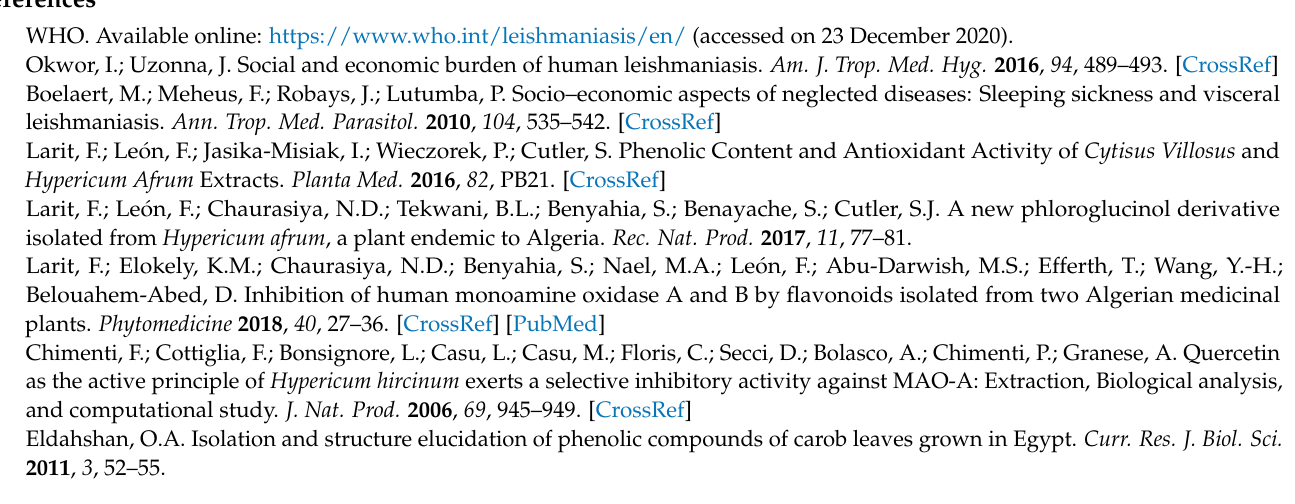
compound 1 , Figure S2: 13 C-NMR spectrum of compound 1 , Figure S3: Positive HRESIMS of compound 1 , Figure S4: 1 H-NMR spectrum of compound 2 , Figure S5: 13 C-NMR spectrum of compound 2 , Figure S6: Negative HRESIMS of compound 2 , Figure S7: 1 H-NMR spectrum of compound 3 , Figure S8: 13 C-NMR spectrum of compound 3 , Figure S9: Positive HRESIMS of compound 3 , Figure S10: 1 H-NMR spectrum of compound 4 , Figure S11. 13 C-NMR spectrum of compound 4 , Figure S12: Negative HRESIMS of compound 4 . Figure S13: 1 H-NMR spectrum of compound 5 , Figure S14: 13 C-NMR spectrum of compound 5 , Figure S15: Negative HRESIMS of compound 5 , Figure S16: 1 H-NMR spectrum of compound 6 , Figure S17: 13 C-NMR spectrum of compound 6 , Figure S18: Negative HRESIMS of compound 6 , Figure S19: 1 H-NMR spectrum of compound 7 , Figure S20: 13 C-NMR spectrum of compound 7 , Figure S21: Negative HRESIMS of compound 7